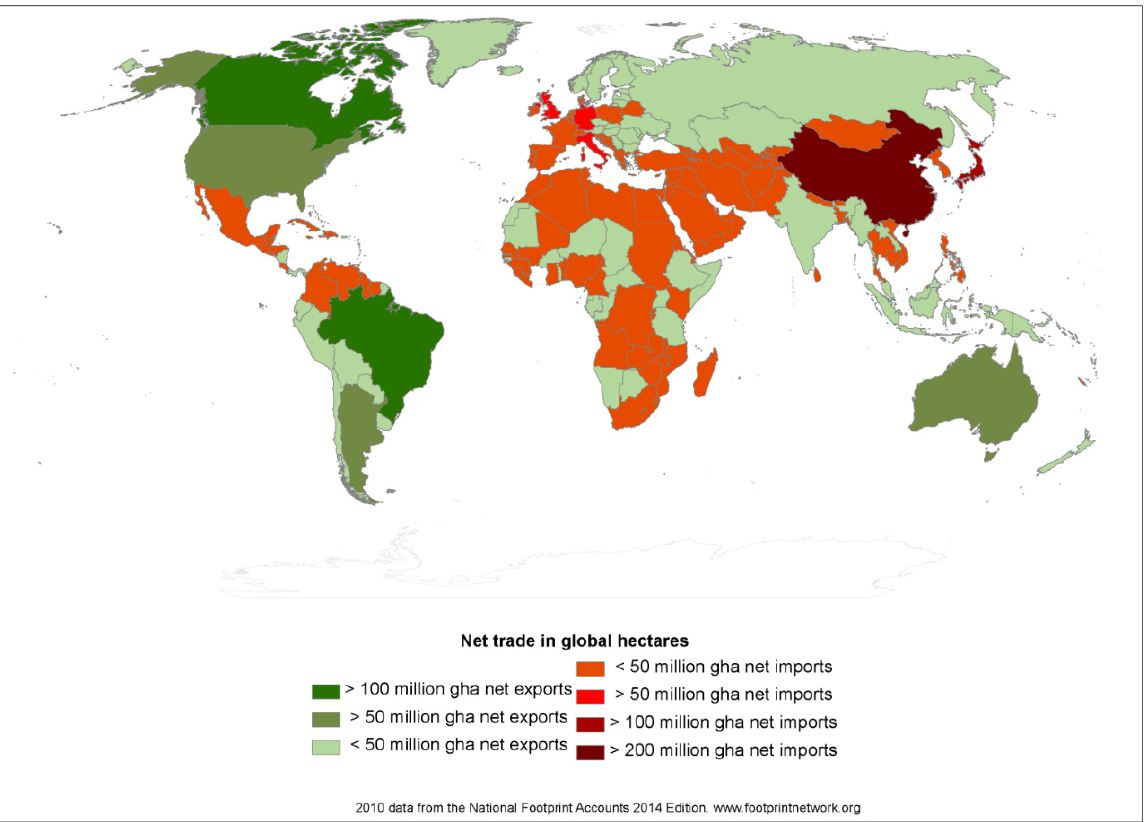
Figure 3. Net trade of biomass biocapacity by